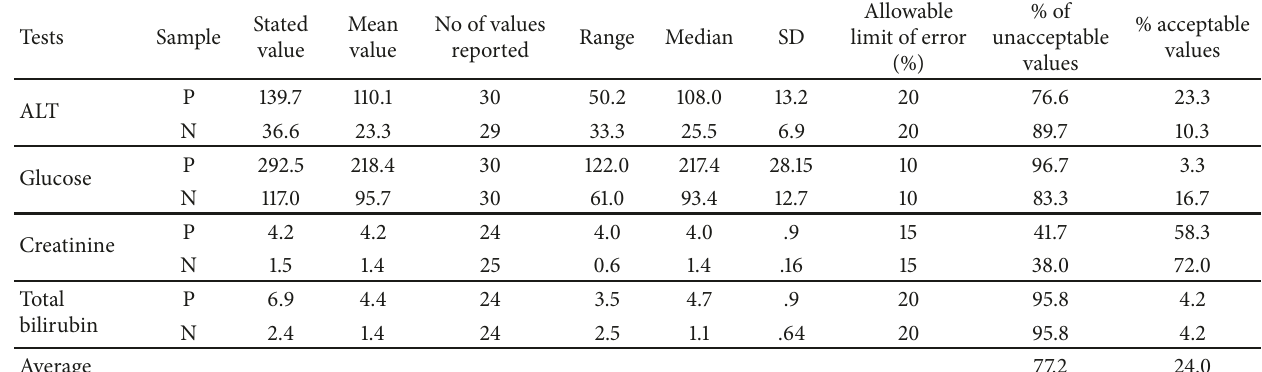
Table 5: Summaries of the results of all test values obtained from two governmental hospitals, two higher clinics, two diagnostic clinics, one other governmental, and three medium clinics laboratories in Jimma zone.